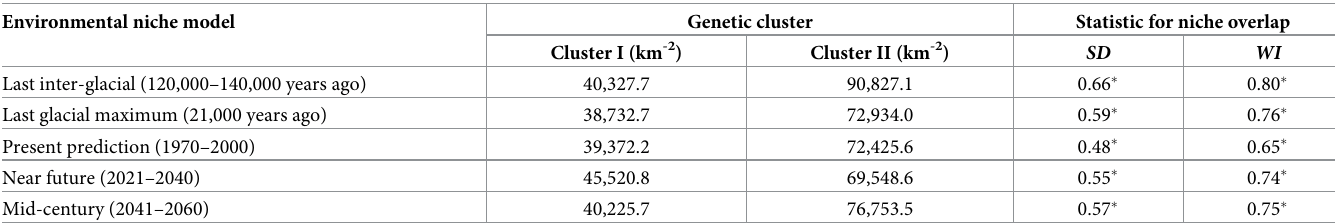
Table 3. Suitable areas and niche identity statistics for two genetic clusters of sideoats grama ( Bouteloua curtipendula ), based on MaxEnt environmental niche mod- els for past, present and future scenarios. Environmental niche